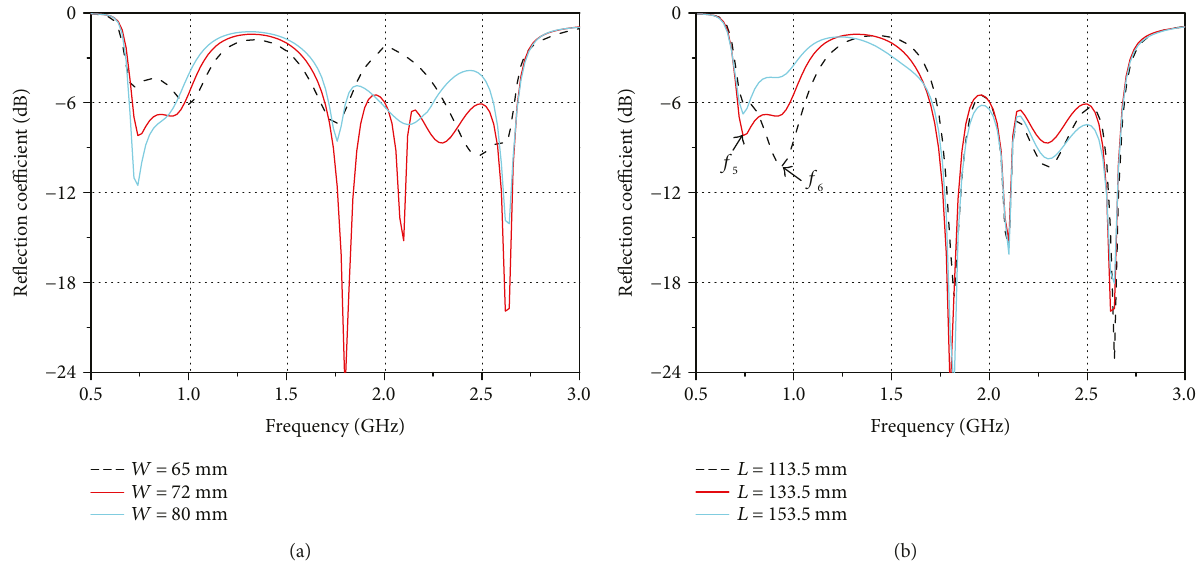
Figure 7: E ff ect of the ground plane on the re fl ection coe ffi cient. (a) Width of the ground plane. (b) Length of the ground